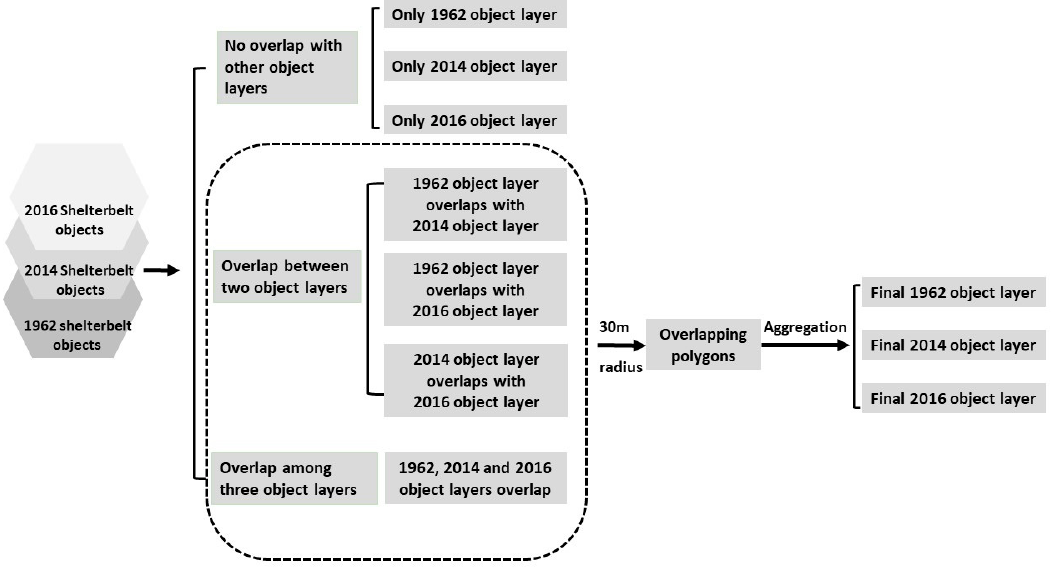
Figure 4. Flowchart showing the possible outcomes from change detection across three object layers.